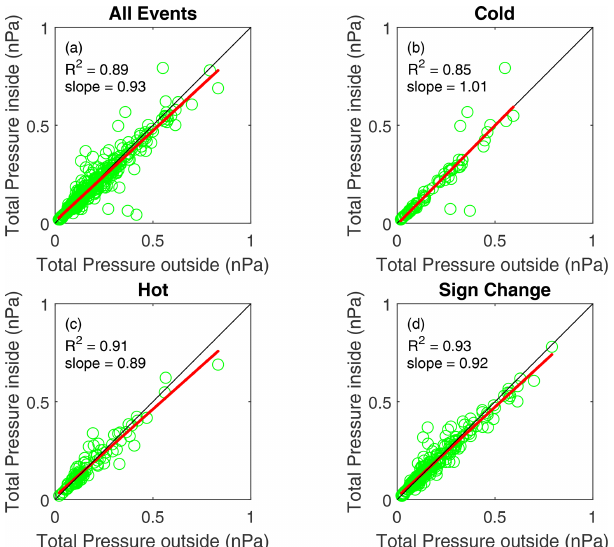
Figure 12. Test of the pressure balance over the structures. The total pressure is calculated at the centre and outside of the structure. (a) Relation for all structures; the black line is the identity, and the red line is a fit to the points. Pressure balances follow for (b) the cold category, (c) the hot category and (d) the sign change category. The regression coefficients and the slopes are listed in the panels.